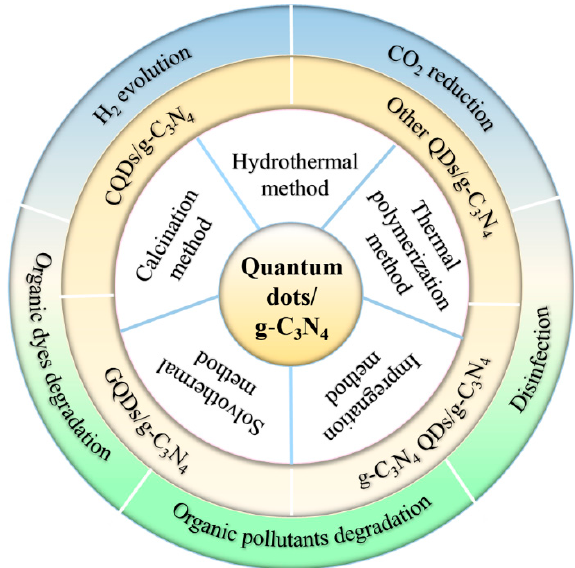
Figure 1. Summary diagram of the synthetic methods, classification, and applications of quantum dots/g-C 3 N 4 photocatalysts.